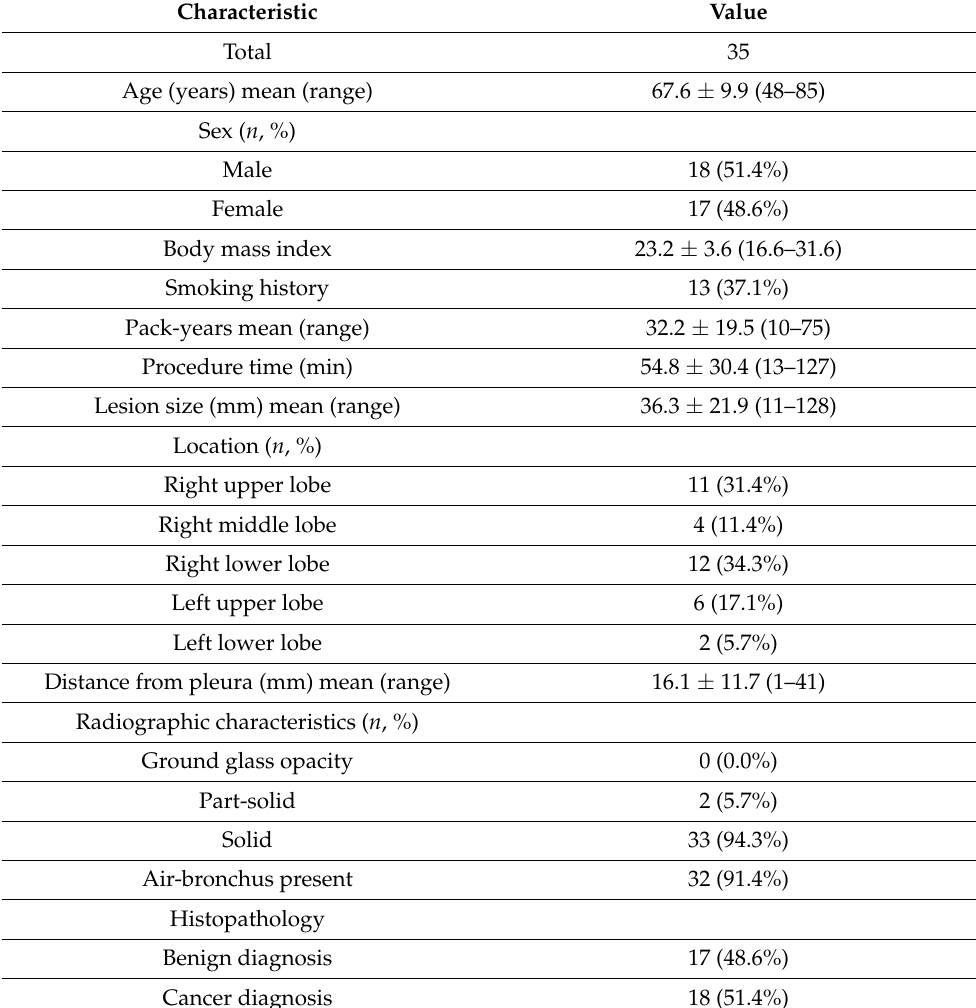
Table 1. Characteristics of the patients and pulmonary